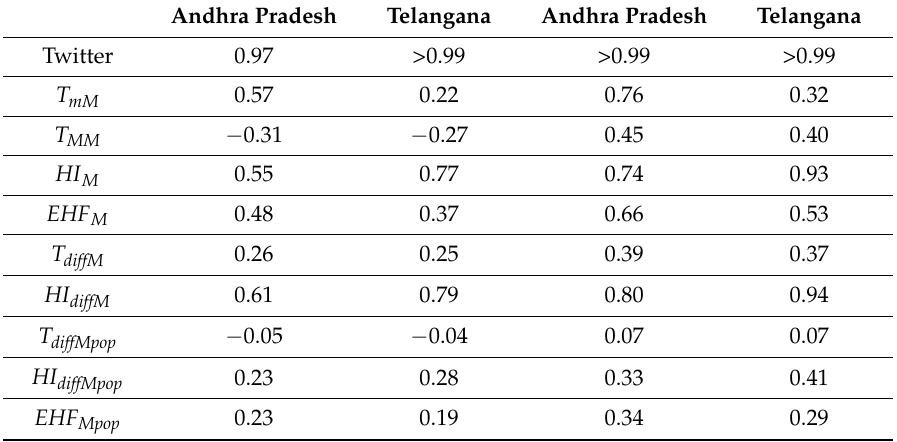
Table 6. Pearson correlation coefficient between IMD mortality data, Twitter and heat wave indicators, together with their significance (1 − p ) for Andhra Pradesh and